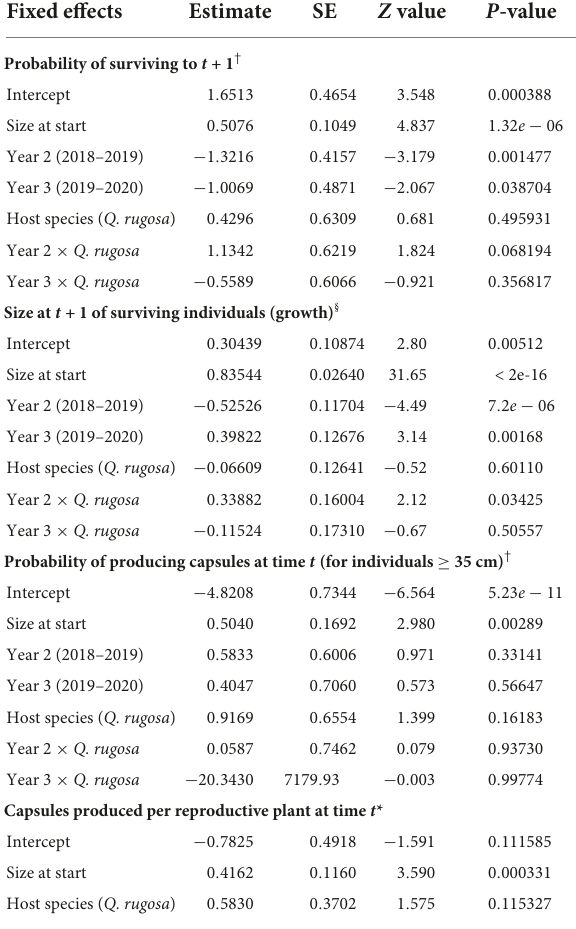
TABLE 3 Estimated coefficients from mixed-effect models of the probability of survival, growth, reproduction, and probability of producing capsules for Alamania punicea plants growing on two Quercus